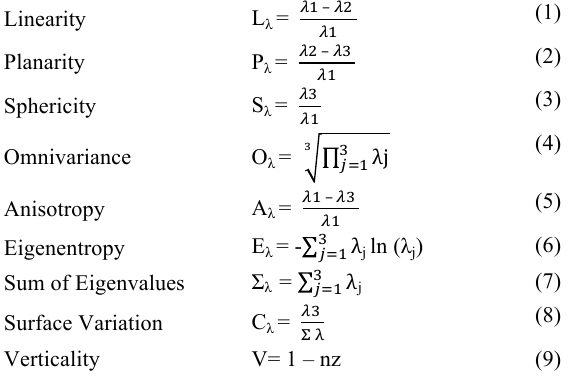
Table 1. Considered local 3D shape features/covariance